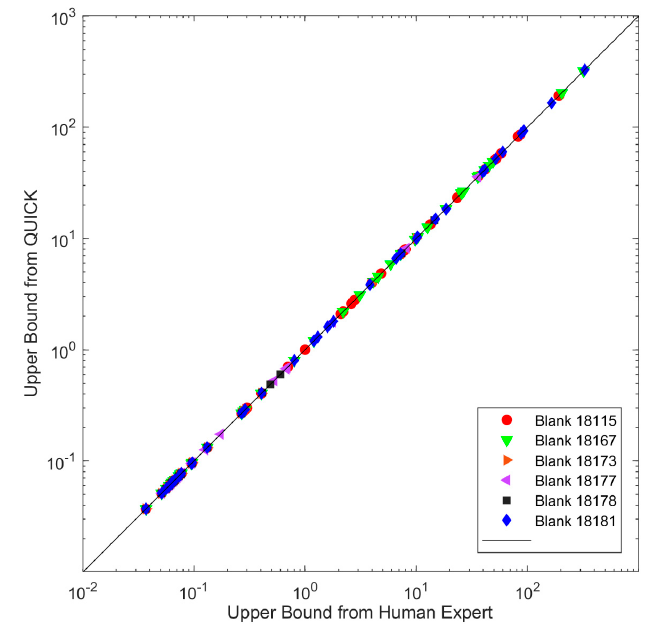
Figure 4. Comparison between the upper bound from QUICK ( y axis) and upper bound from the human expert ( x axis) for congeners of six Blank Data sets (solid red circles: data from Blank 18115; solid green down triangles: data from Blank 18167; solid orange right triangles: data from Blank 18173; solid purple left triangles: data from Blank 18177; solid black squares: data from Blank 18178, solid blue diamonds: data from Blank 18181). If a data point is on the diagonal line, the concentrations from QUICK and the human expert are the same for the congener.